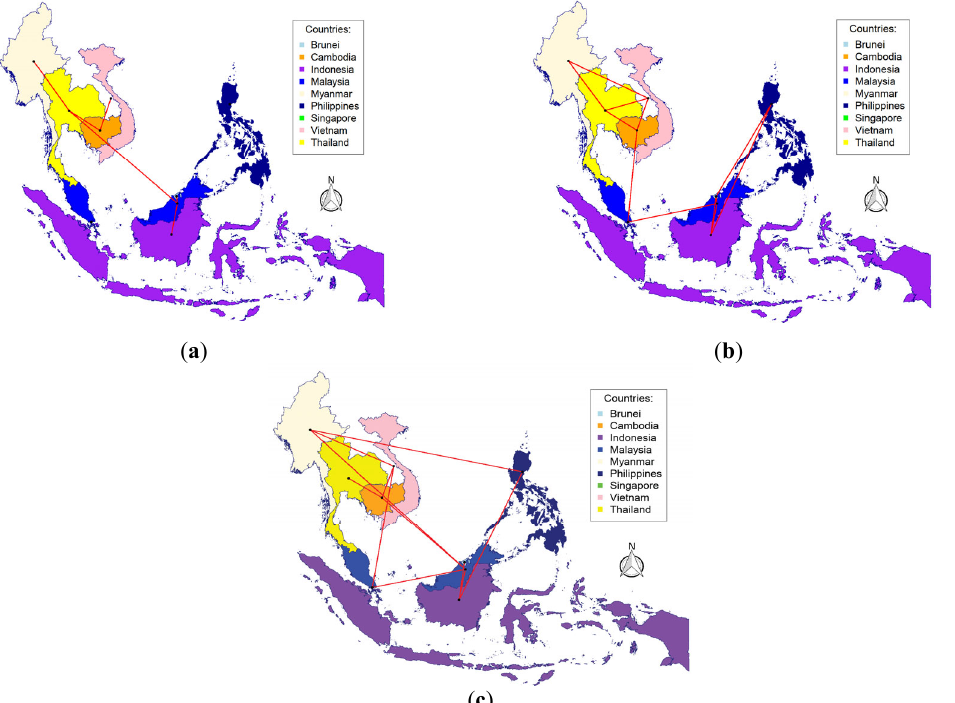
Fig. 4 . Spatial weighted matrix map: (a) queen contiguity; (b) 2-NN; ( c ) customized. Source: primary data processed with the R software.